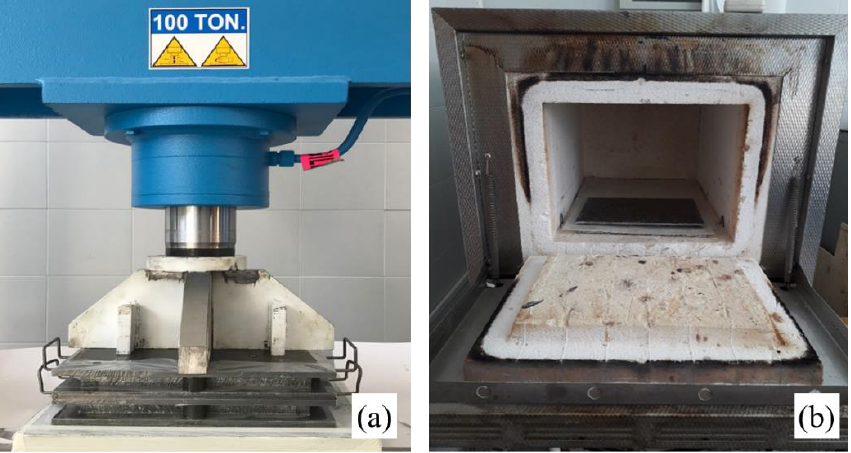
Figure 2. ( a ) Compression-molding performed by hydraulic press, and ( b ) post-curing performed by electrical oven.